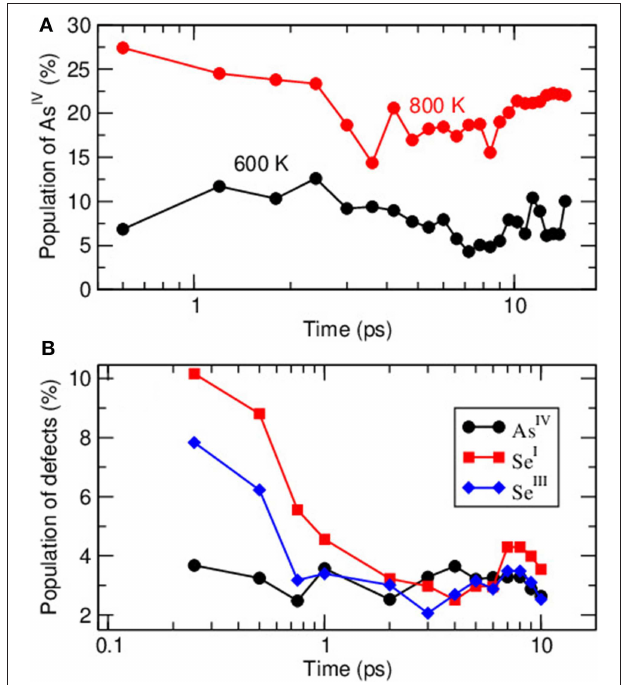
FIGURE 6 | Calculated fraction of As IV in liquid (600 K and 800 K) As 2 Se 3 with simulation time (A) and time evolution of defect species (As IV , Se I , and Se III ) from a hyperquenched stable liquid to 300 K (B)